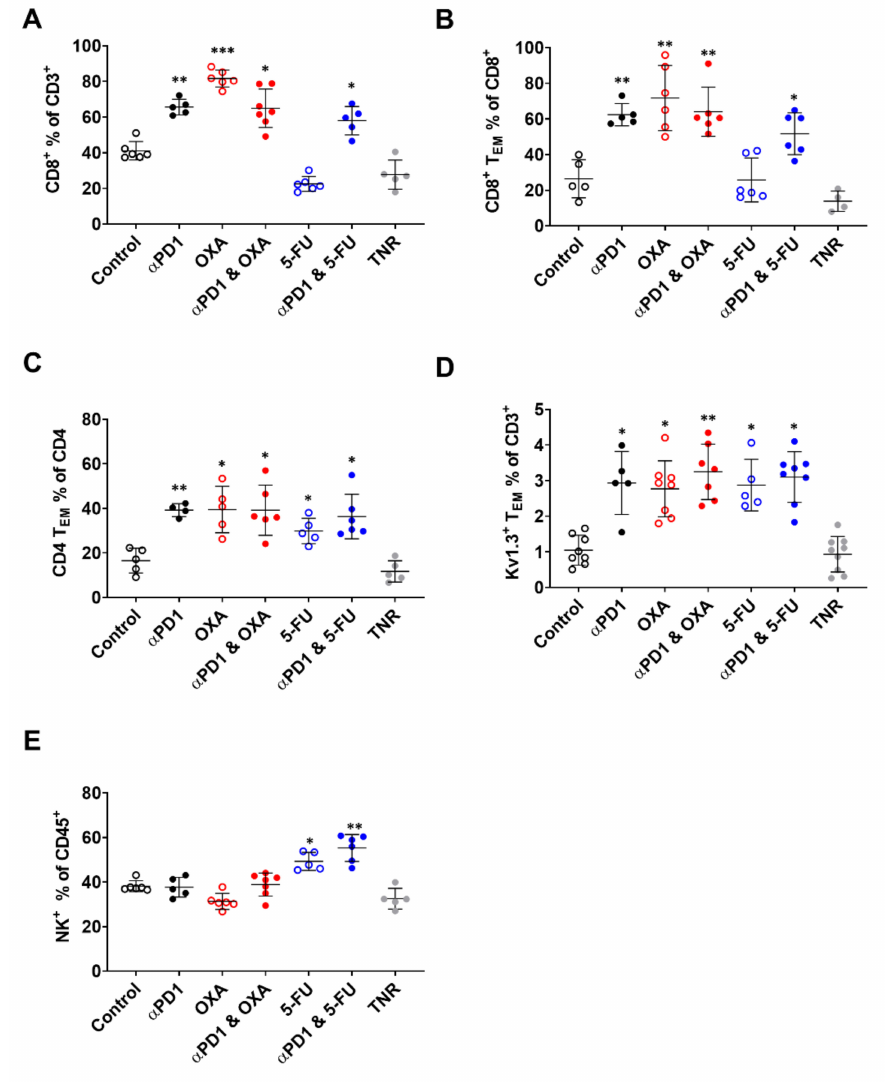
Figure 3. Flow cytometry depicting tumour-infiltrating i mmune cell populations in each treatment arm. Percentages of ( A ) CD8 + T-cells relative to CD3 + cells, ( B ) CD8 + T EM cells relative to total CD8 + cells, ( C ) CD4 + T EM cells relative to total CD4 + cells, ( D ) Kv1.3 + T EM cells relative to total CD3 + cells and ( E ) NK + cells relative to total CD45 + cells across all treatment arms. Data are individual values with the mean ± S.D. and are representative of n = 4–7 mice/group. * p < 0.05; ** p < 0.01; *** p < 0.001 compared to